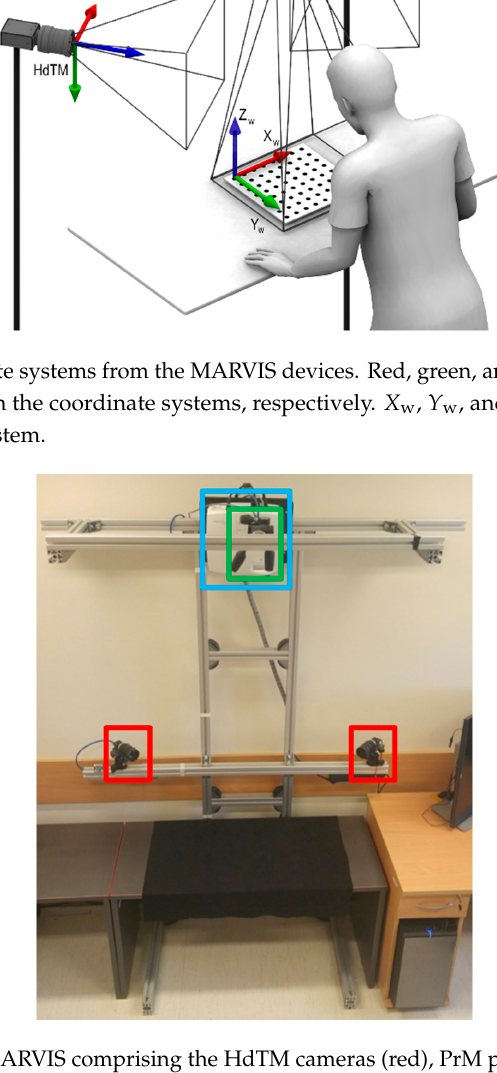
Figure 10. User’s syringe probe used to detect needle pricking into the liver phantom. Figure 11. ( A )—Liver phantom without projection, ( B )—rendered 3D scene for current position, and ( C )—liver phantom illuminated by projector. MARVIS generates an OpenGL scene of a liver model, including its internal structures, at each timeframe and projects its transformed image onto the physical phantom. First, a scene is rendered with respect to the user’s viewpoint (Figure 12, step 1), beginning with the phantom shell without internal structures. Next, the system renders the internal structures in a separate framebuffer for superimposition onto the framebuffer with the shell image, disregarding depth information from the Z -axis buffer (Figure 12, projection of A onto A p ). The system then virtually re-projects the pixels (Figure 12, step 2) from the user’s viewpoint onto the liver phantom surface based on the global coordinate system and projects these pixels onto the projector image plane (Figure 12, step 3). Therefore, the PrM accesses the information required to display an image with suitable perception characteristics for the operator (Figure 12, step 4).